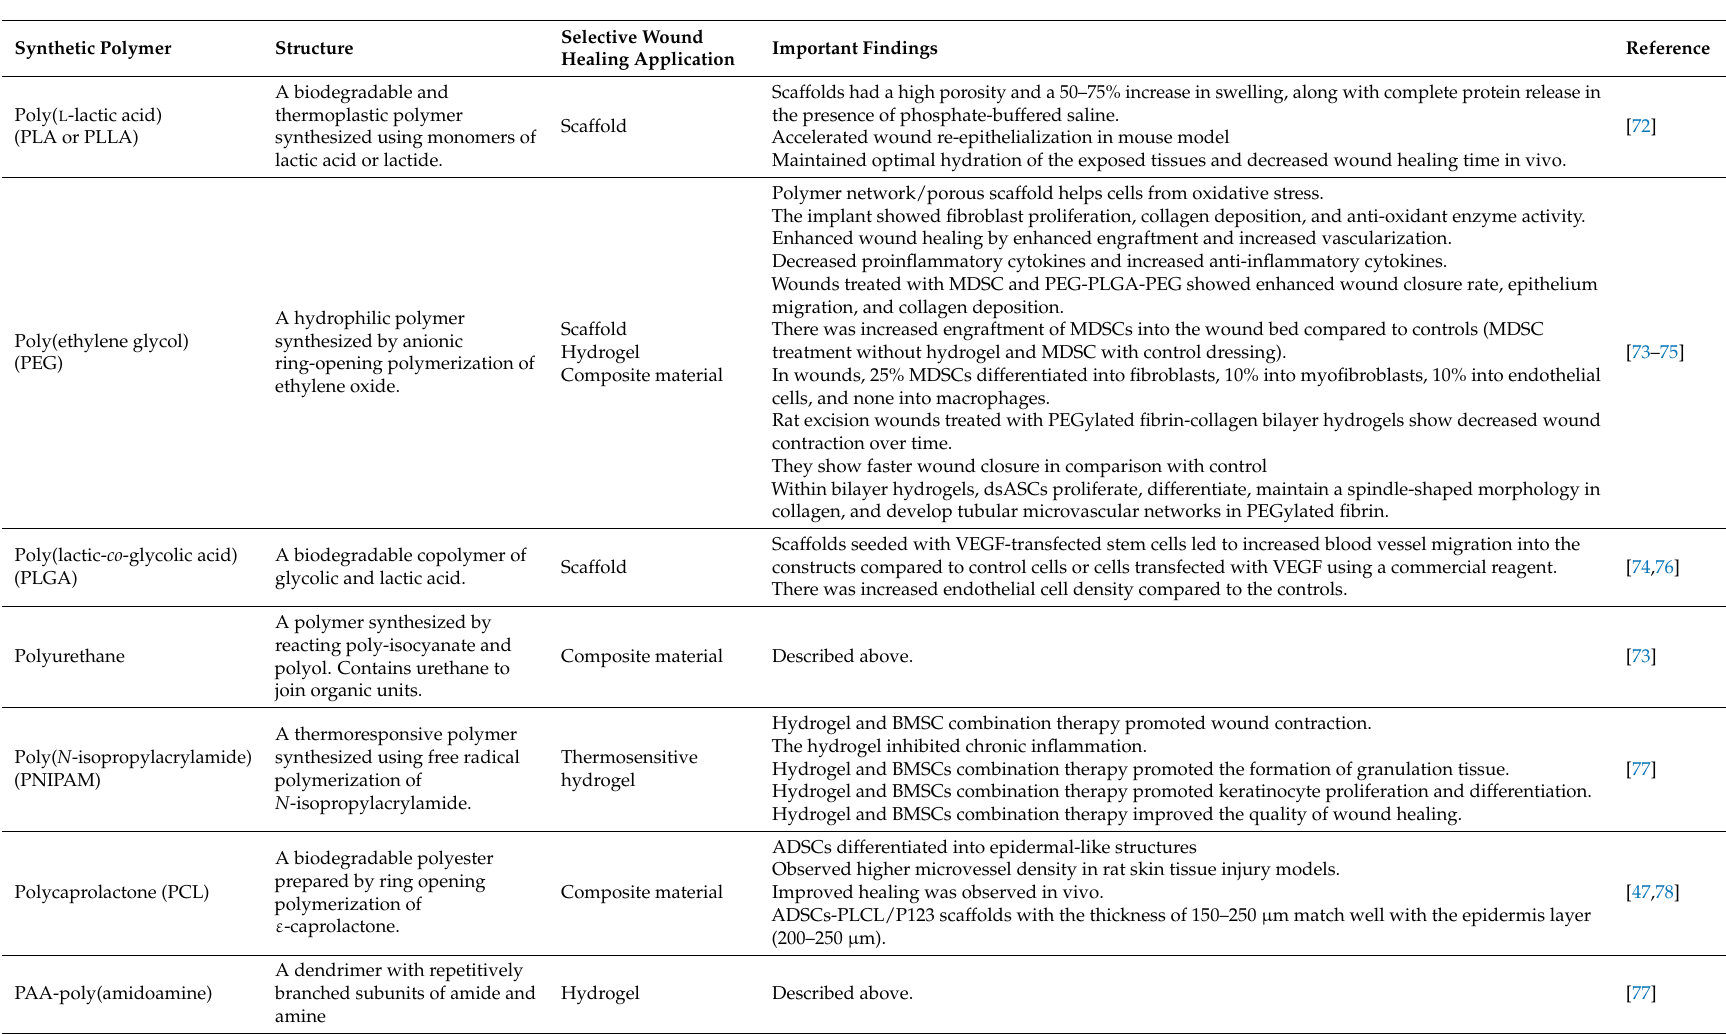
Table 2. Synthetic polymers for wound healing